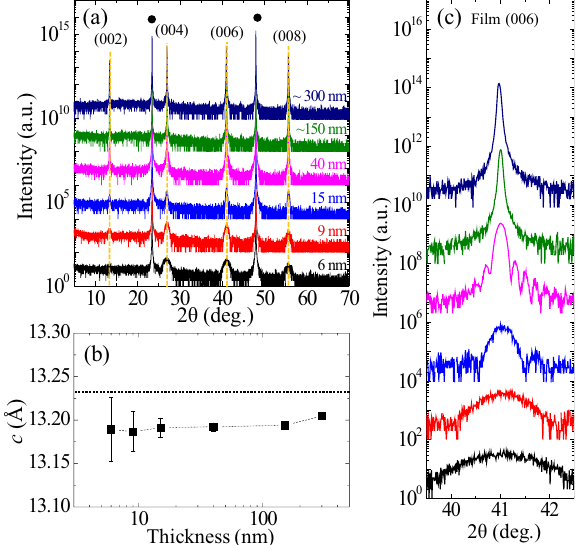
Figure 3. Crystal structural characterization by x-ray diffraction. ( a ) X-ray 2 θ − ω scans for La 1.85 Sr 0.15 CuO 4 thin films on LaAlO 3 substrate. Black circles represent the peaks of LaAlO 3 substrate. Vertical orange dashed lines exhibit the peak positions of the La 1.85 Sr 0.15 CuO 4 films were almost identical regardless of different film thicknesses. ( b ) c -axis lattice parameter versus logarithmic film thickness. Error bar was evaluated from the FWHM of (006) peak. ( c ) The enlarged 2 θ − ω scans for (006) peaks. The thicknesses of films thinner than 100 nm were defined by the Kiessig fringes and/or the Scherrer formula, while the two thickest films were estimated by growth time.